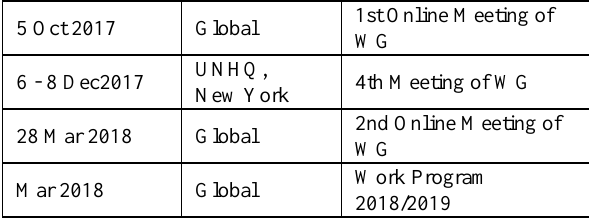
Table 2. The progress of IAEG-SDGs: WGGI